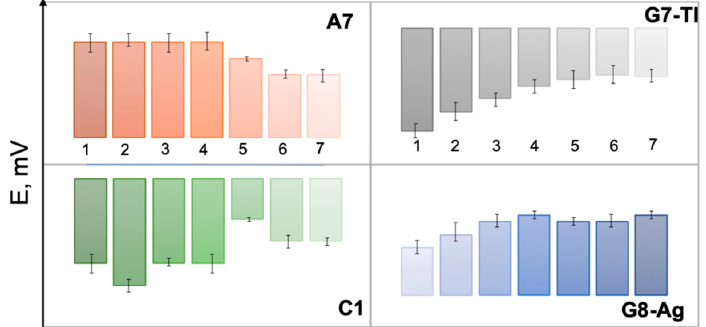
Figure 3. The responses of individual sensors A7, C1, G7-Tl, and G8-Ag in aqueous solutions of geosmin (GE) and 2-methyl-isoborneol (MIB) in concentrations (from left to right) (1): 25, (2): 50, (3): 100, (4): 500 ng/L, (5): 1, (6): 10, and (7): 100 μ g/L.